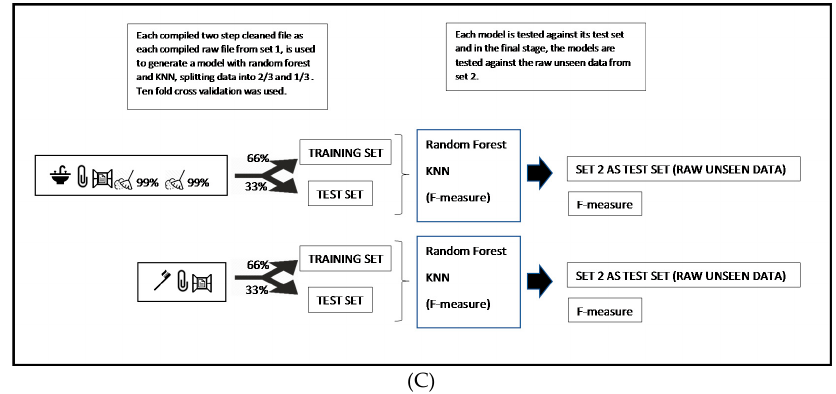
Figure 1. ( A ) Proposed approach representation. This representation corresponds to stage 2 of the process. ( B ) Proposed approach representation. This diagram corresponds to the stage 3 of the process, in particular to phases 1 to 5. ( C ) Proposed approach representation. This diagram corresponds to the stage 3 of the process, phases 6 to 8.